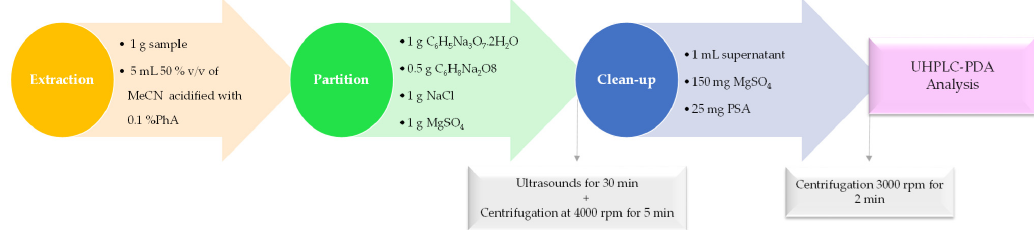
Figure 1. Schematic representation of the quick, easy, cheap, effective, rugged and safe followed by dispersive solid phase extraction (QuEChERS ‐ dSPE) procedure.